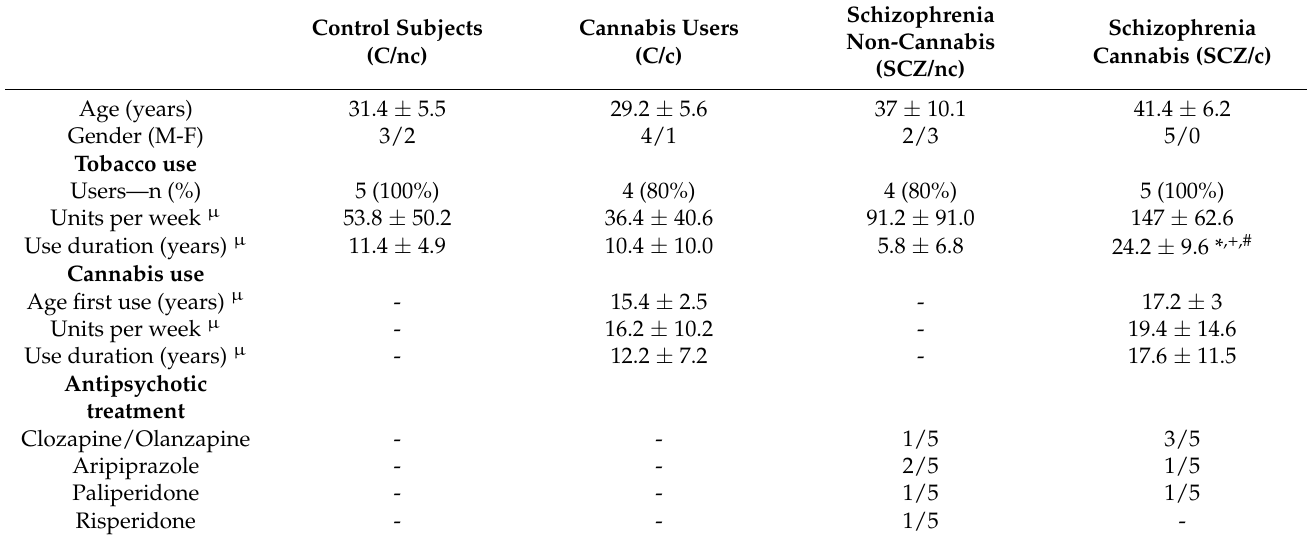
Table 1. Demographic characteristics of the different groups included in the study.